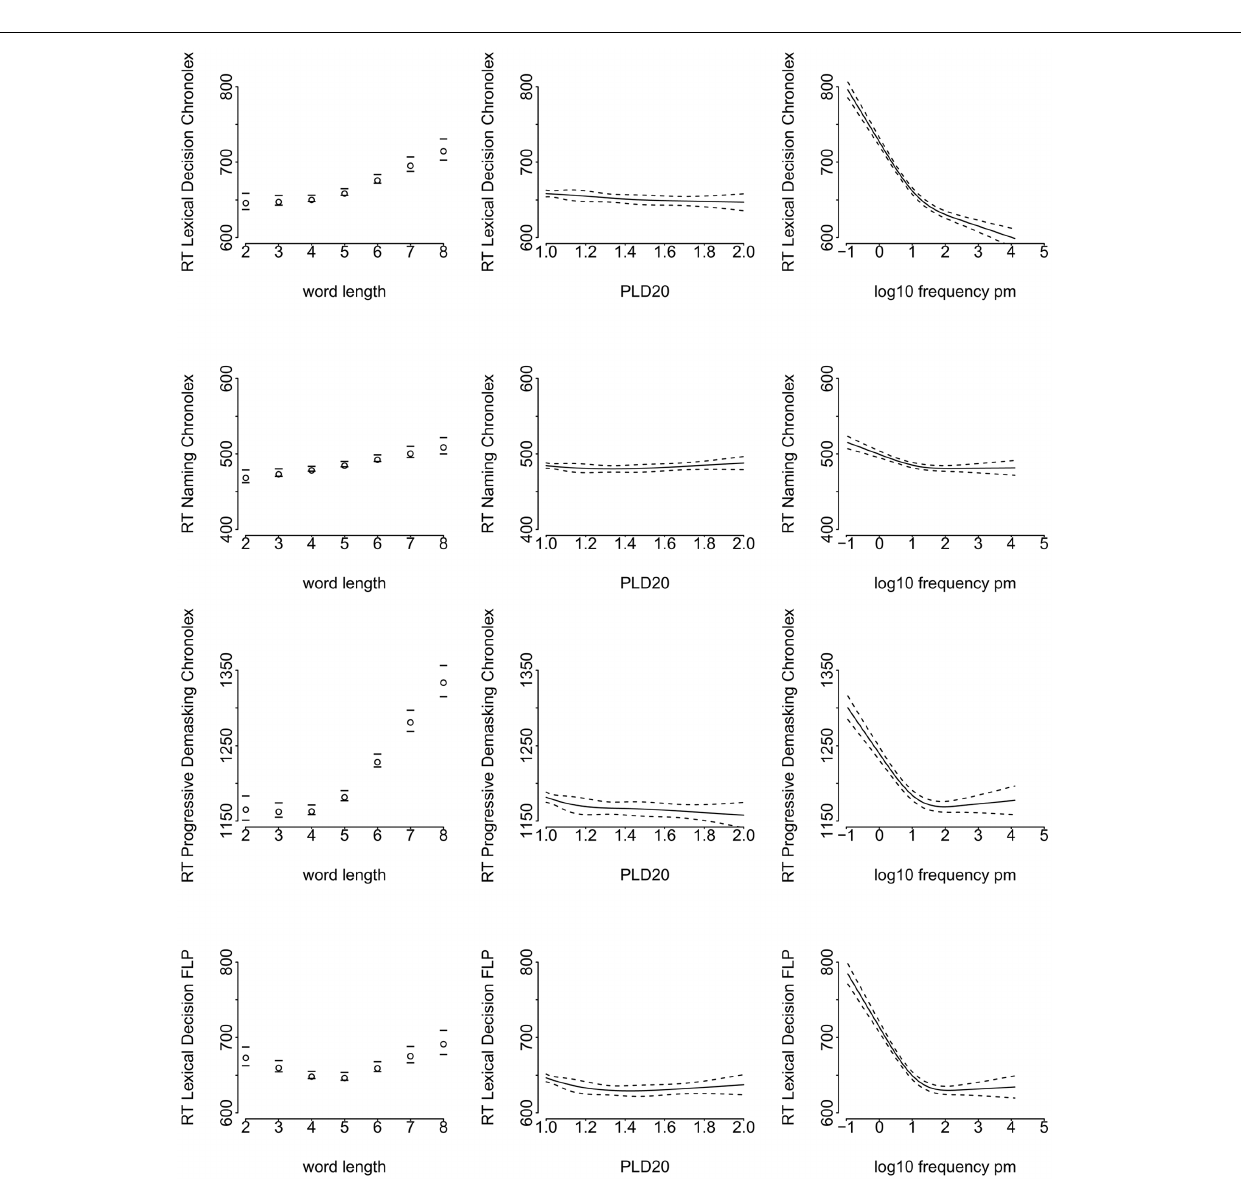
FIGURE 1 | Effects of word length, PLD20, and log frequency on the Chronolex data (lexical decision, naming, and progressive demasking; first three lines) and the lexical decision data of FLP (last line). (95% confidence intervals indicated by dashed lines).